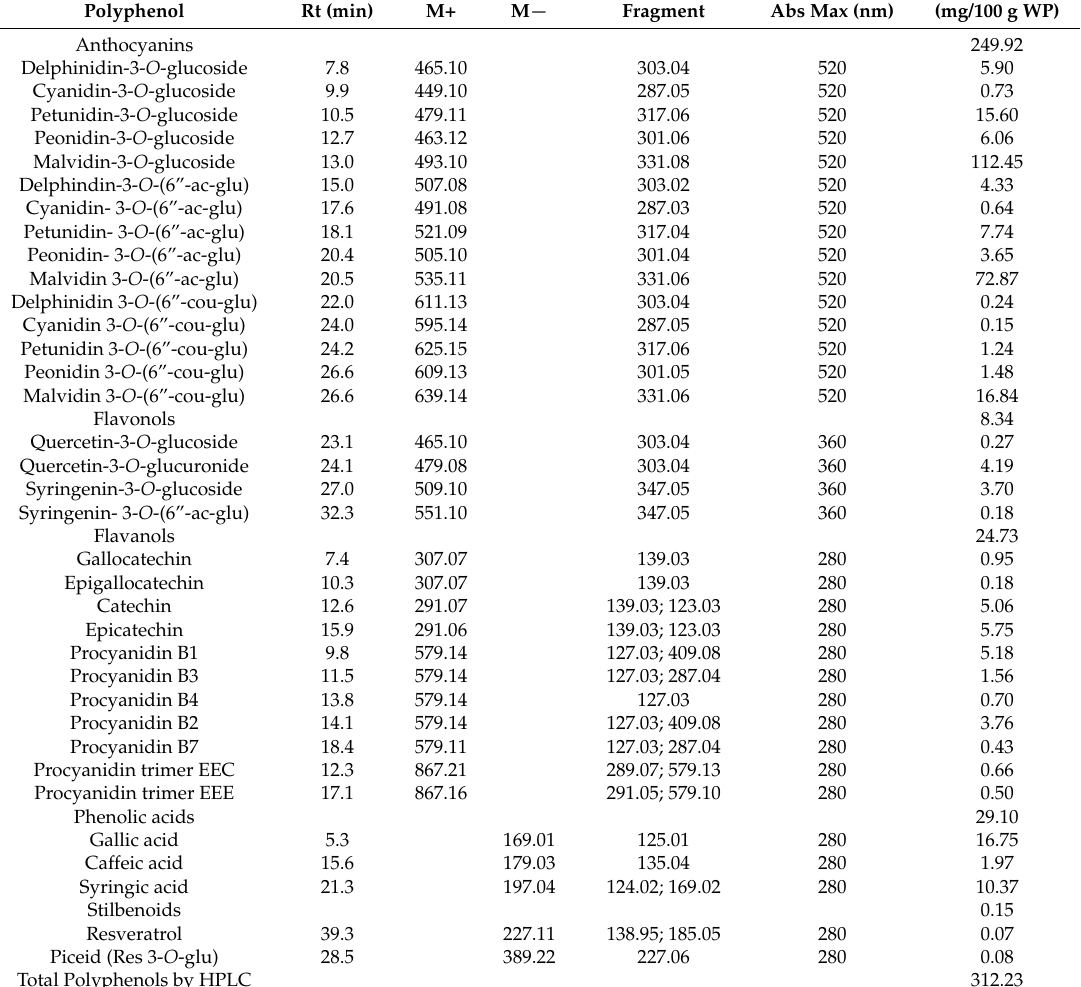
Table 1. Polyphenols present in encapsulated WP as identified by HPLC-QTOF.